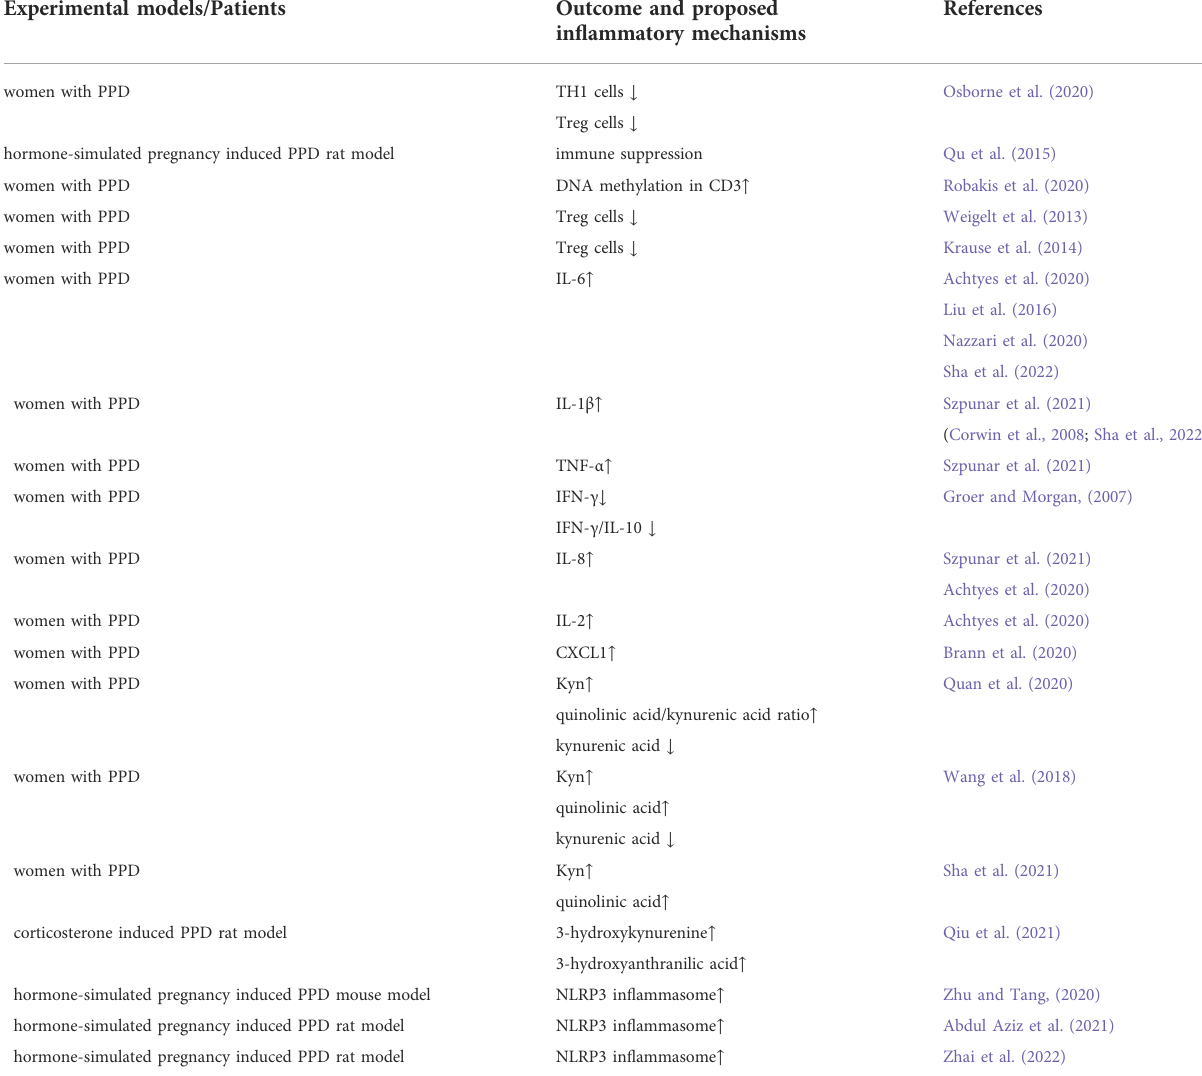
TABLE 1 The summary of in fl ammatory pathophysiological mechanisms implicated in postpartum depression. Experimental